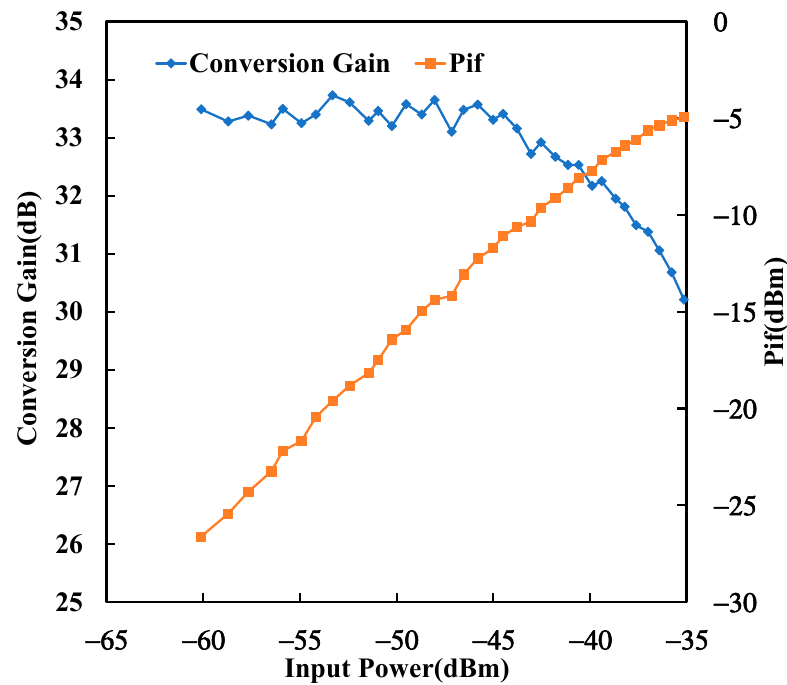
Figure 18. The conversion gain and NF measurement results. The VCO is measured by the spectrum analyzer FSW85. A tuning range from 70.5 to 78.2 GHz, i.e., a 10.4% fractional range, is achieved, as shown in Figure 19. Meanwhile, the phase noise at 1 MHz offset frequency is − 91.8~ − 93.48 dBc/Hz, and the phase noise of 77.74 GHz is shown in Figure 20. The phase noise measurements are bigger than the simulated results by 1~2 dB.